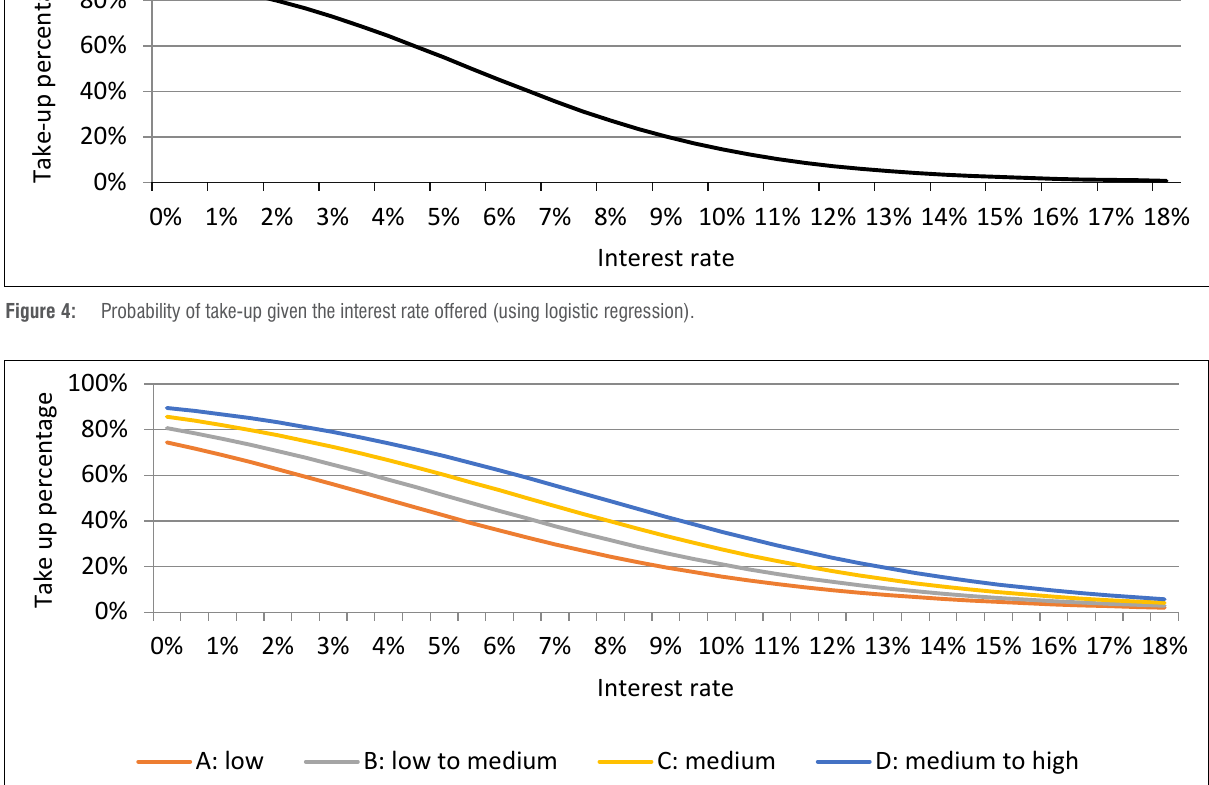
Figure 5: Probability of take-up given the interest rate offered (per risk